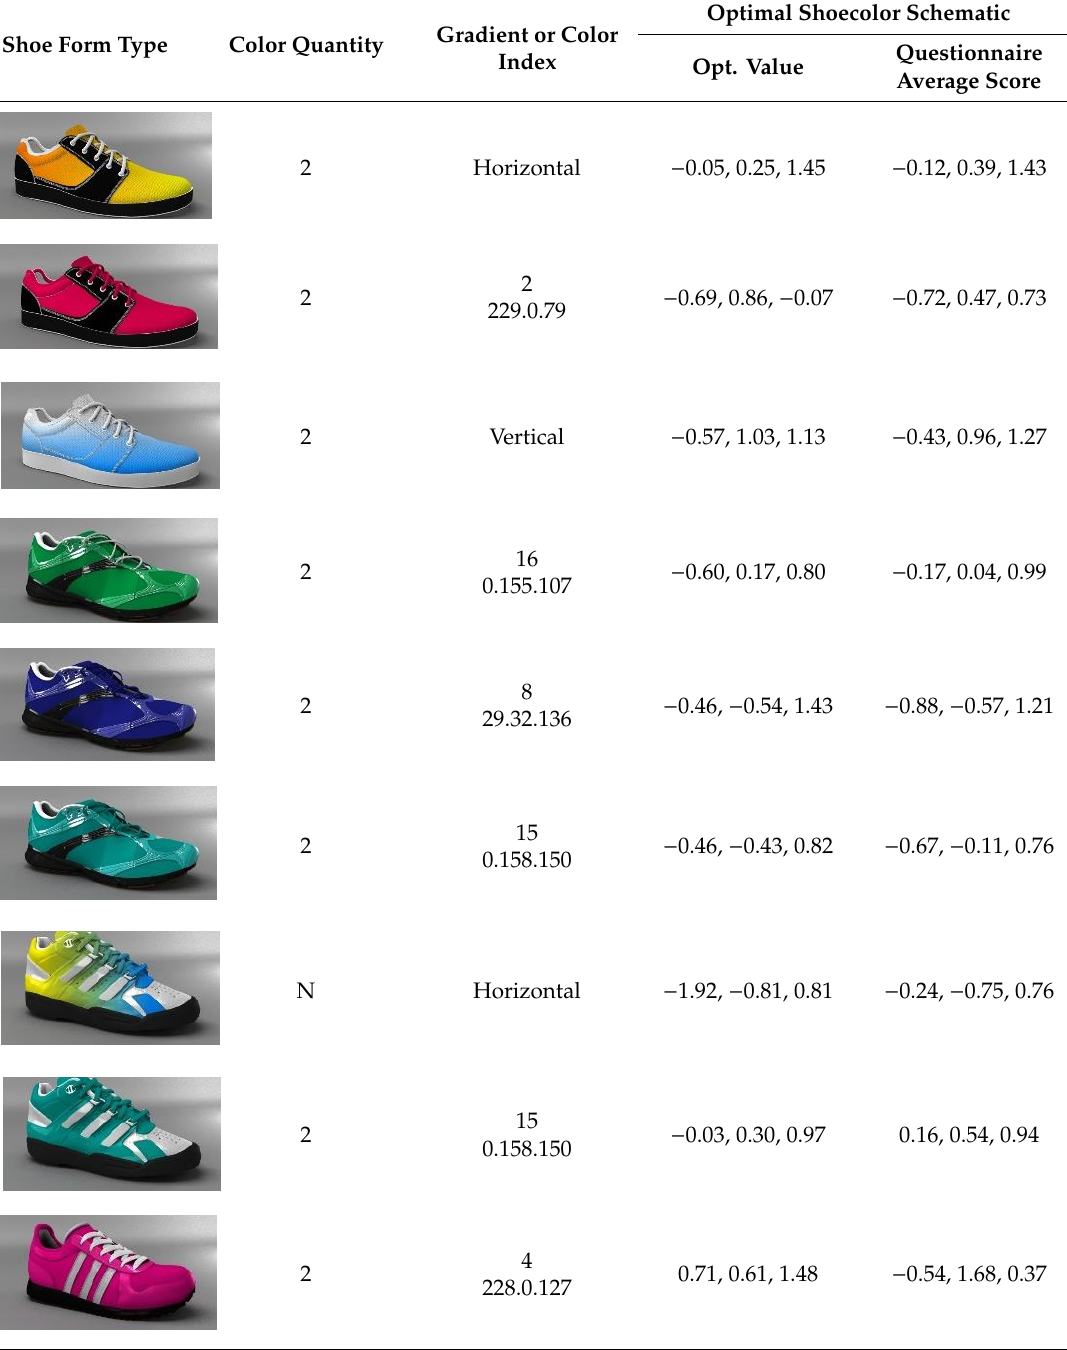
Table 8. Close-to-optimal parameters generated by GA optimization on the trained ANN model.